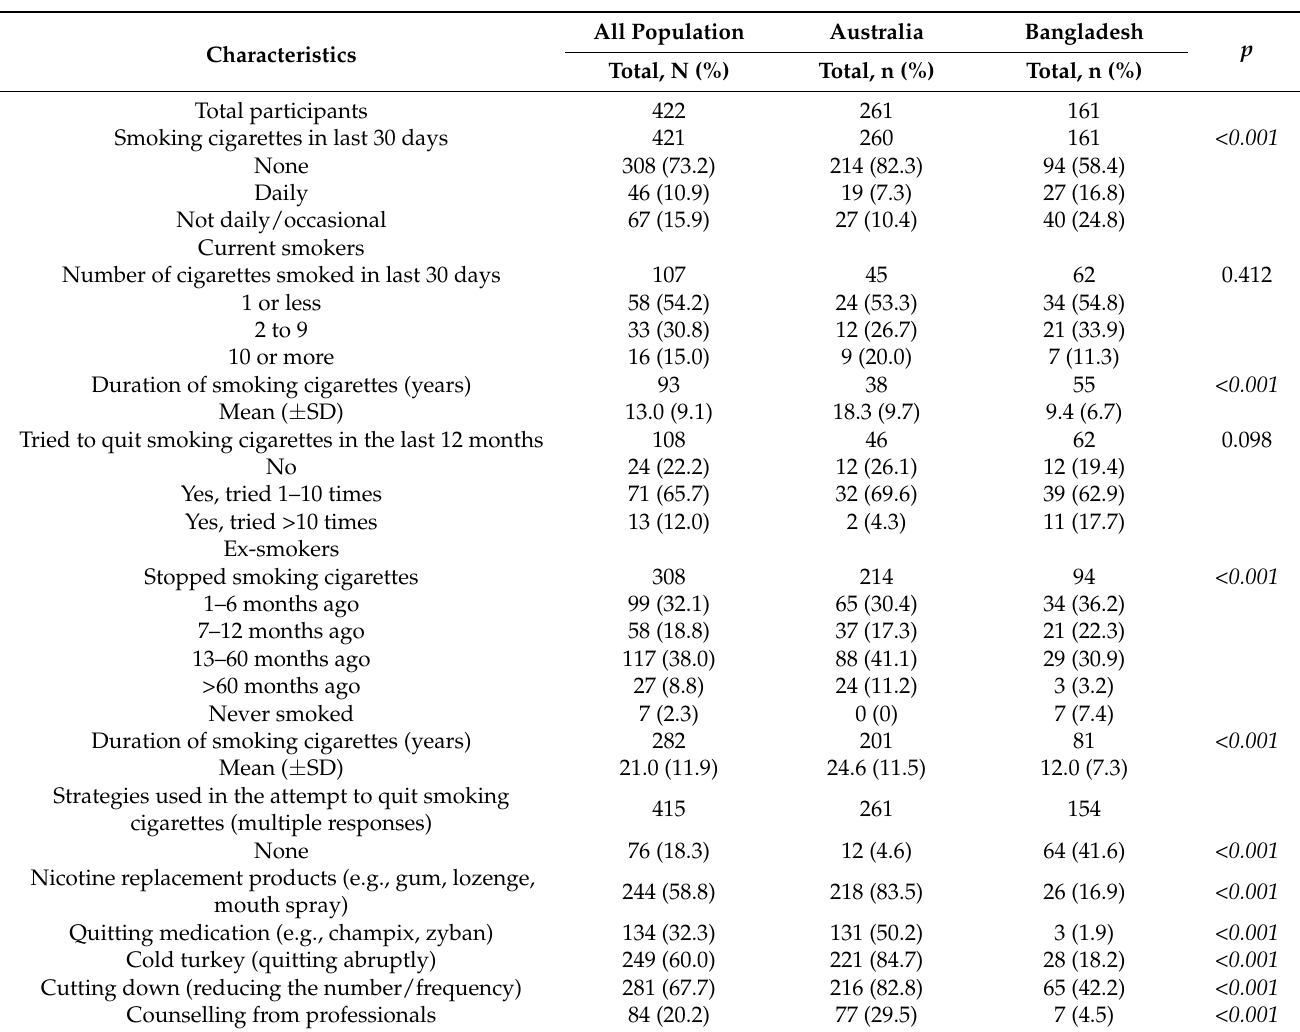
Table 2. Smoking behaviour of the study